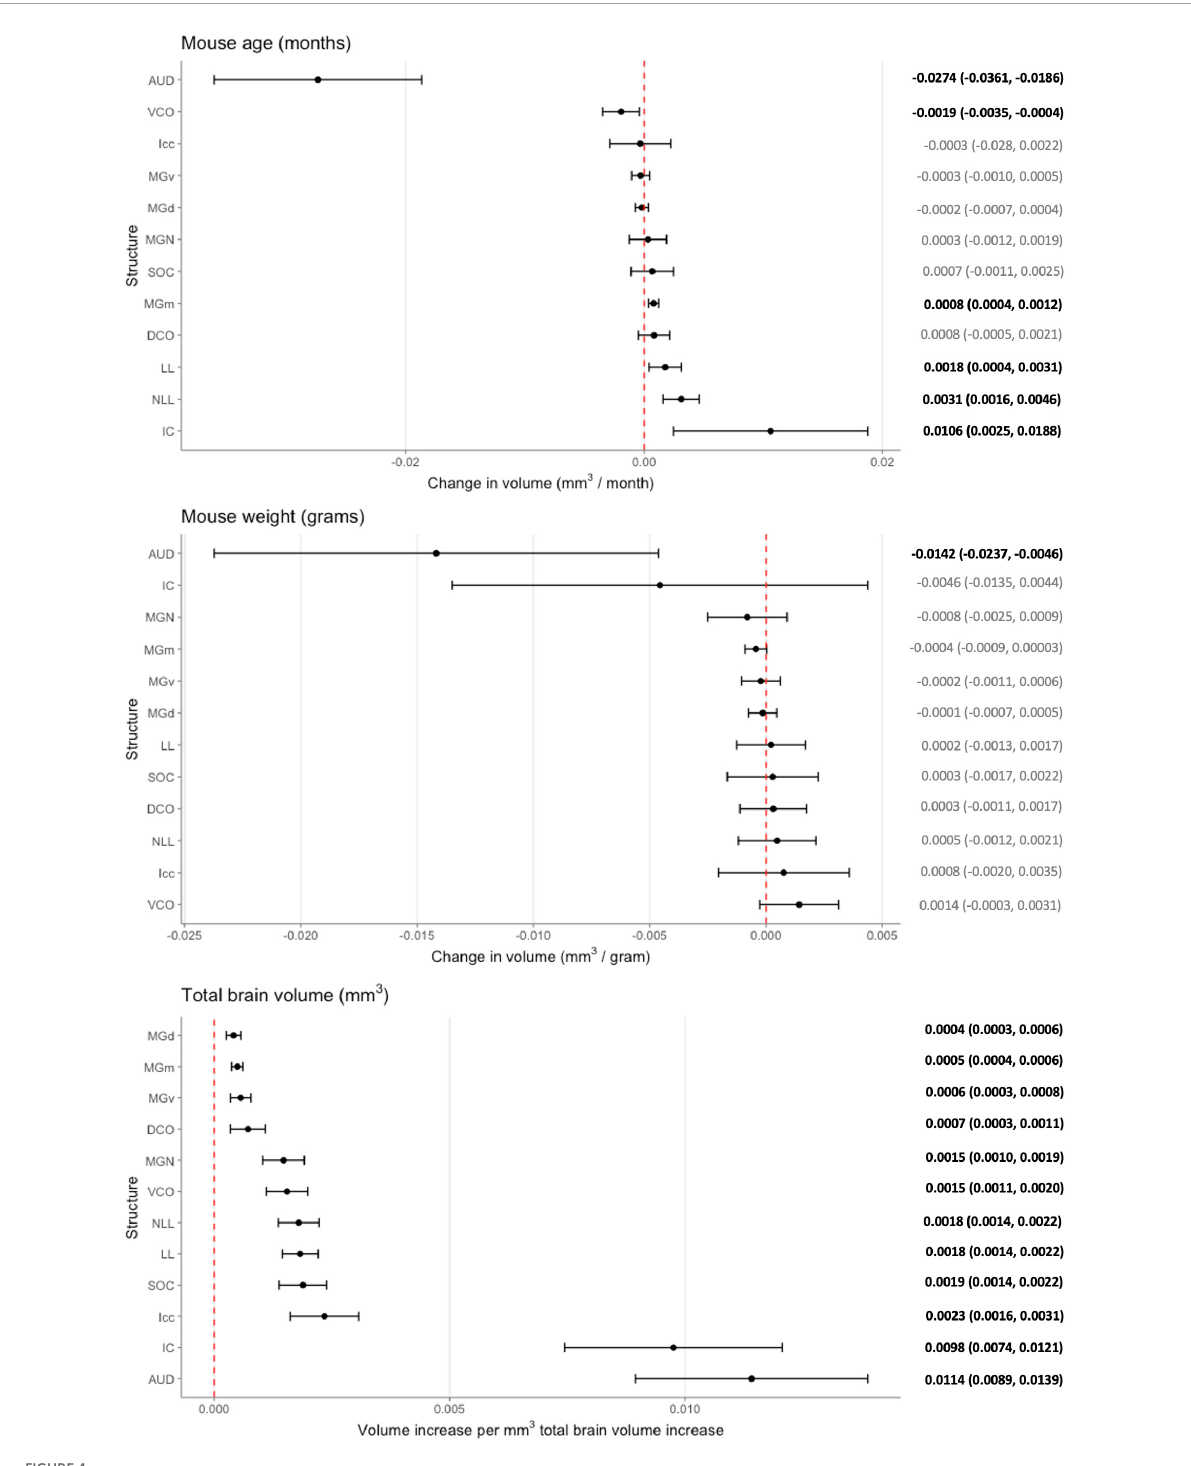
FIGURE4 Multivariable analysis of the association of mouse age, weight, and total brain volume on auditory structure volume. Markers indicate degree of individual structure change per month mouse age (top) , gram mouse weight (middle) , and mm 3 total brain volume (bottom) , respectively. Horizontal lines indicate 95% confidence intervals. Raw coefficient values with their 95% confidence intervals were listed on the right with bolded values indicating significance. Structures were arranged from the lowest to greatest coefficient in each chart. AUD, Auditory cortex; MGd, Medial geniculate nucleus, dorsal part; MGv, Medial geniculate nucleus, ventral part; MGm; Medial geniculate nucleus, medial part; MGN, Medial geniculate nucleus; IC, Inferior colliculus; Icc, Inferior colliculus, central nucleus; LL, Lateral lemniscus; NLL, Lateral lemniscus, nucleus; SOC, Superior olivary complex; DCO, Dorsal cochlear nucleus; VCO, Ventral cochlear